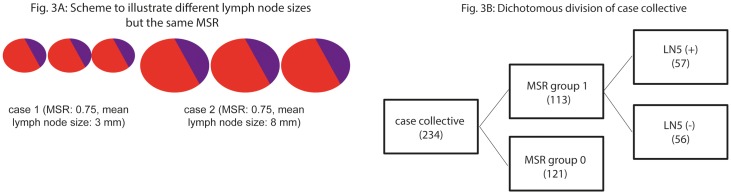
Virtual scheme to illustrate different lymph node sizes but the same MSR (A); dichotomous division of case collective (B).